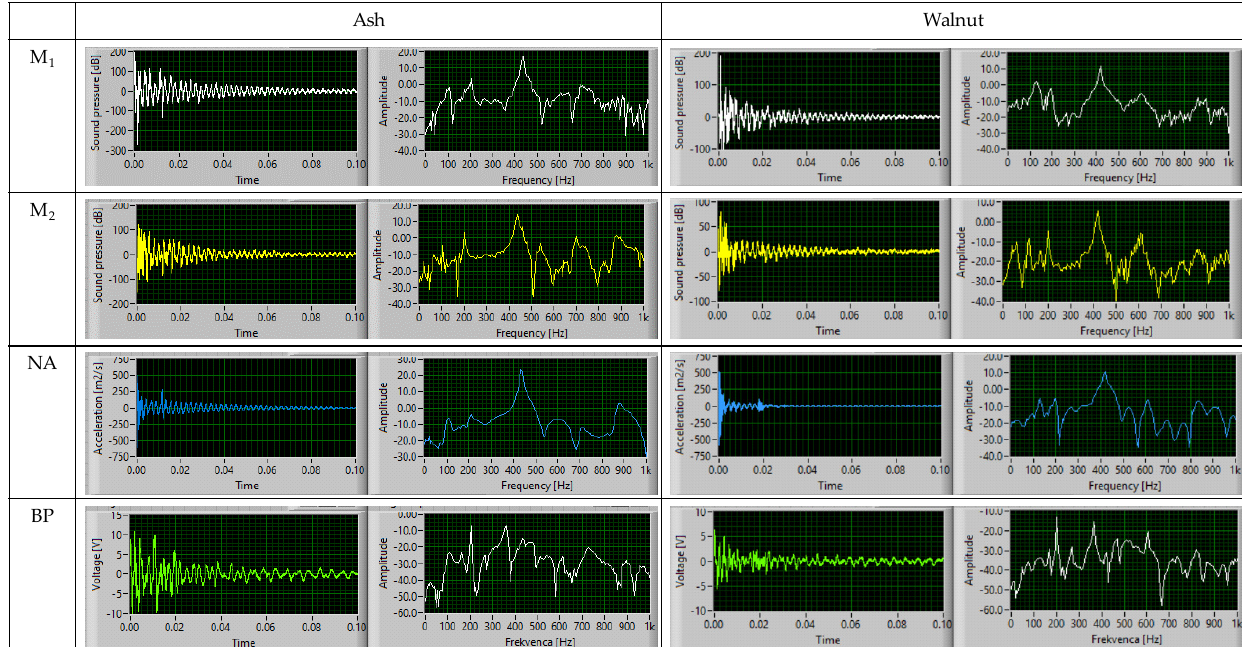
Figure 3. Acquired signals in time ( left ) and frequency domain ( right ) on tested positions of guitars after impulse mechanical excitation (M 1 —body microphone; M 2— edge body microphone; NA—8th fret of fingerboard; BP—body pickup) with body made of ash and walnut wood.